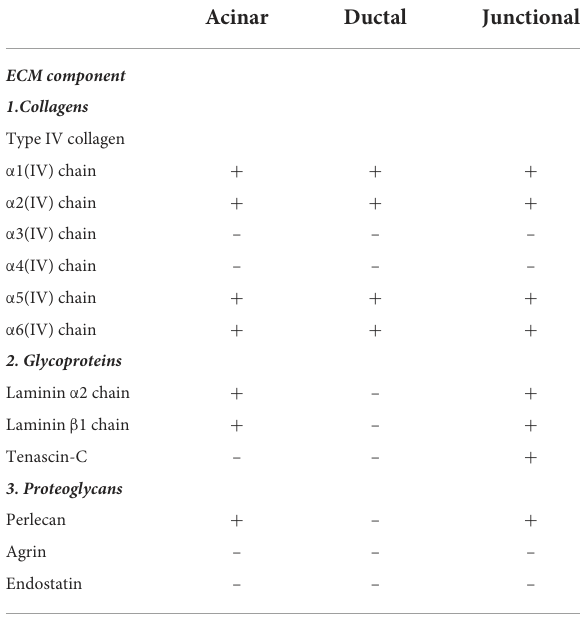
TABLE 2 Expression pattern of extracellular matrix components in human meibomian gland. Acinar Ductal Junctional